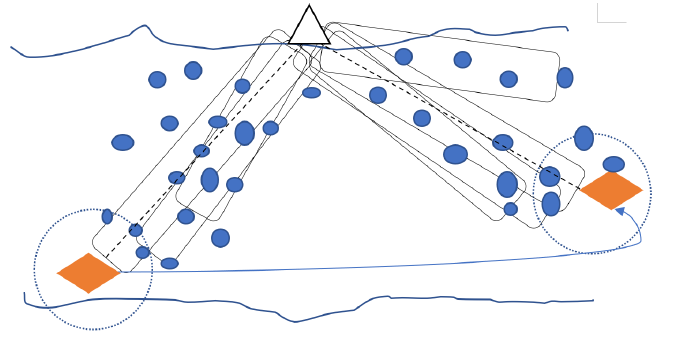
Figure 4. The schematic diagram of virtual pipelines in M-UWSNs.